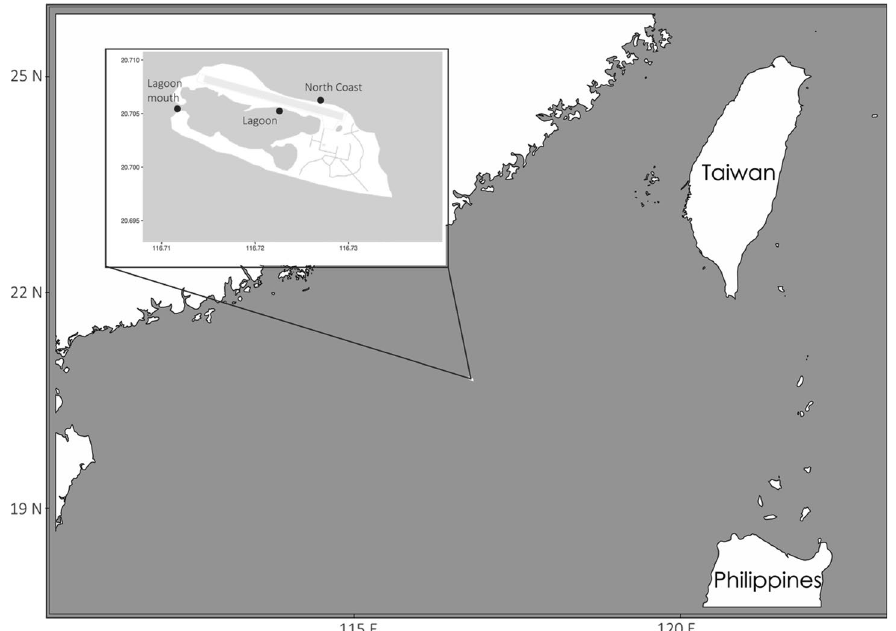
Figure 1. Sampling map of this study which generated by R package ggmap version 3.0.1 (https:// github. com/ dkahle/ ggmap) and ggOceanMaps version 1.3.7 (https:// mikko vihta kari. github. io/ ggOce